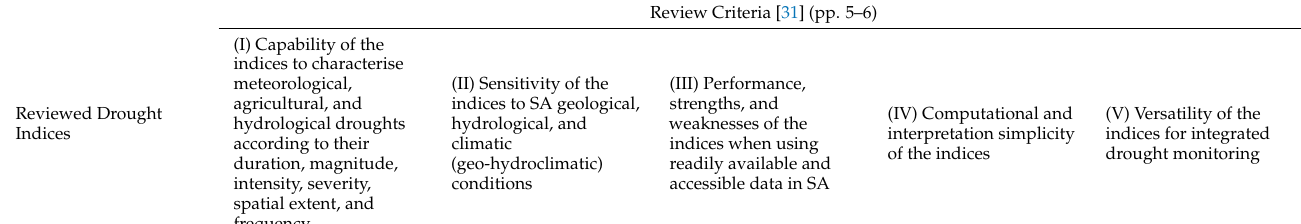
Table 6. Review of the SGI; based on the 2016 WMO Handbook of Drought Indicators and Indices [31] (pp.